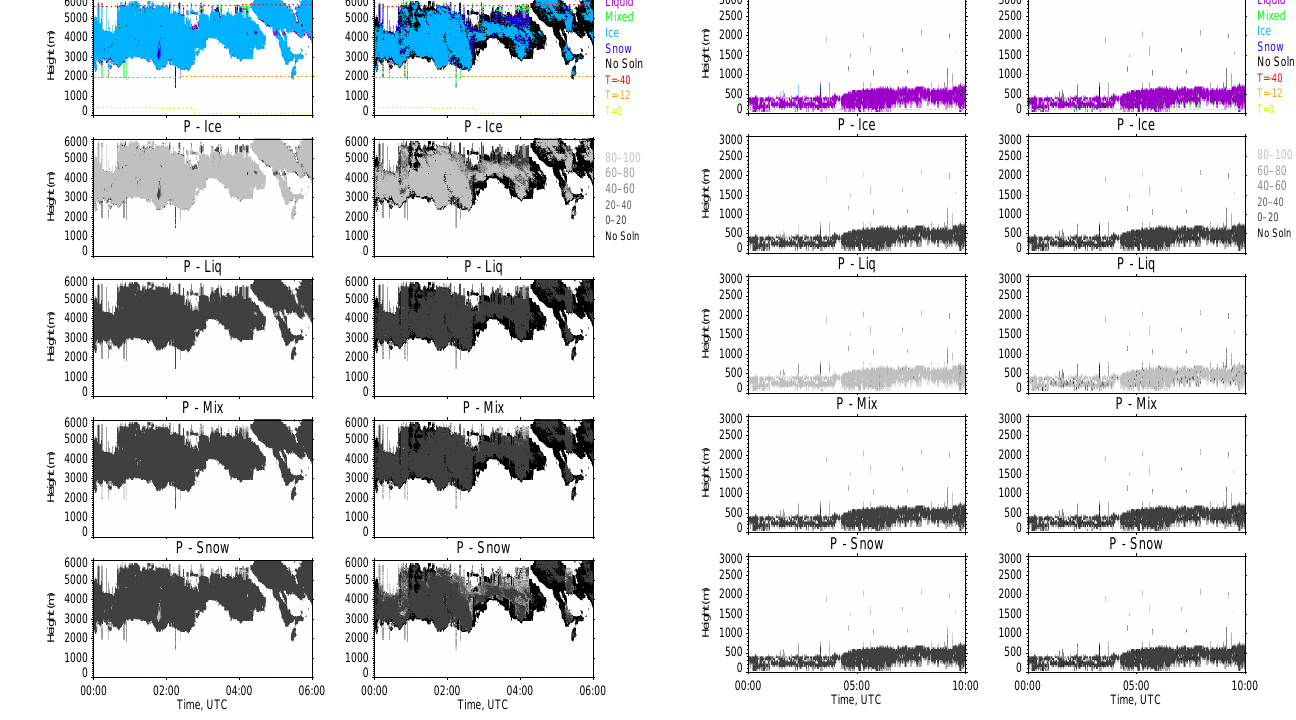
Figure 11. As in Fig. 10, but for 22 October 2004. Figure 12. As in Fig. 10, but for 4 October